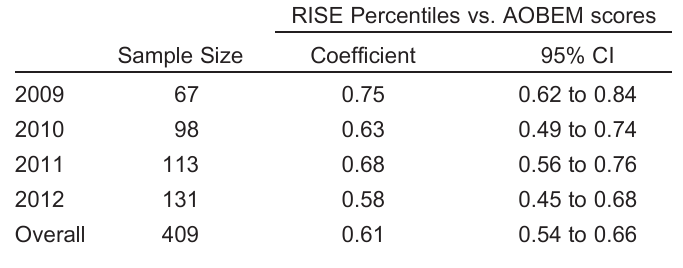
Table 2. The Pearson correlation between Resident In-Service Examination (RISE) percentiles and American Osteopathic Board of Emergency Medicine (AOBEM) Part 1 scores for post graduate year-4 residents who took both exams in the same year from 2009 to